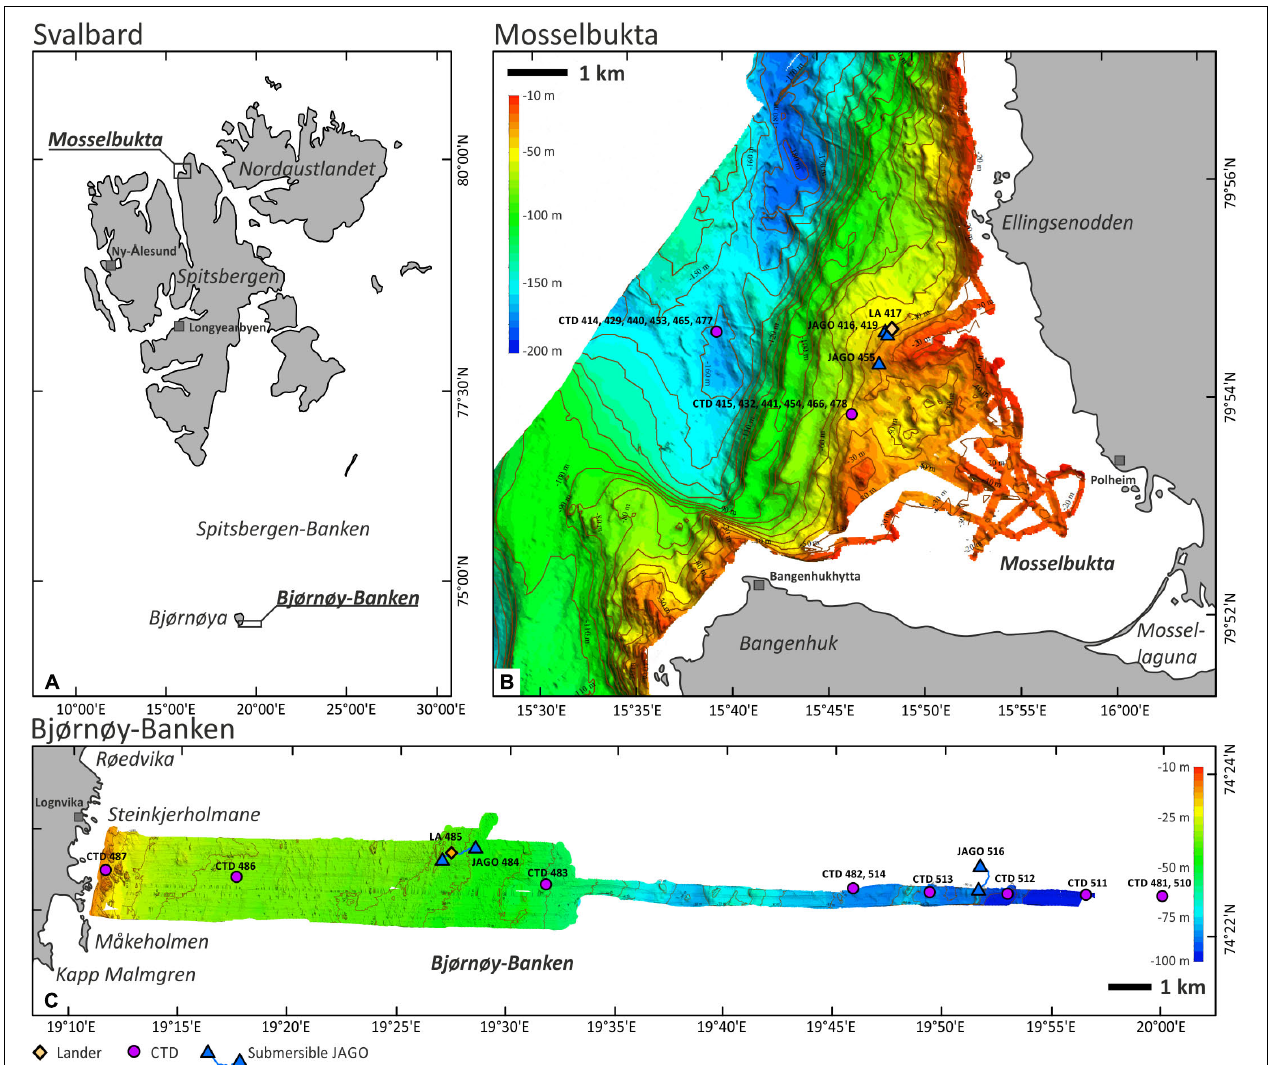
FIGURE 1 | (A) The Svalbard Archipelago (Norwegian legislation) and the location of the two study sites. (B) Mosselbukta in the north of Spitsbergen with the MSM55 multi-beam bathymetry and the location of the relevant CTD, SaM Lander, and JAGO stations. (C) Bjørnøy-Banken in the far south of the archipelago with the MSM55 multi-beam bathymetry and the location of the relevant CTD, SaM Lander, and JAGO stations.